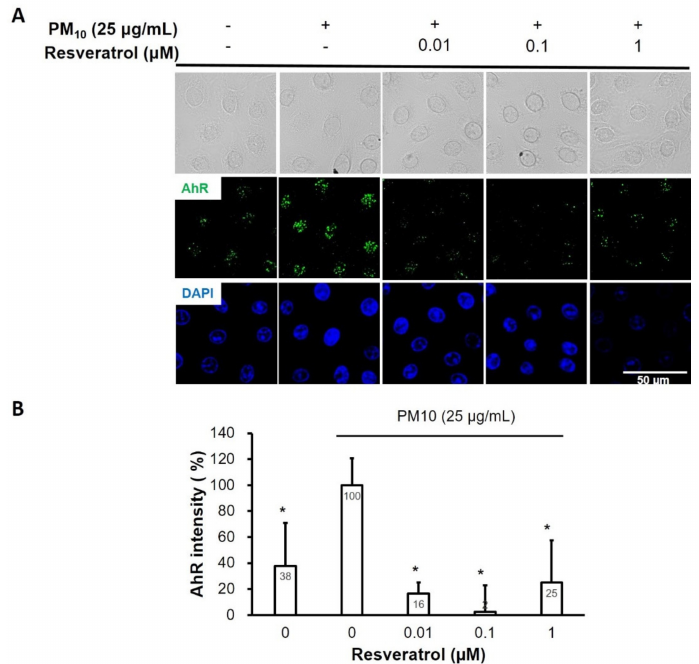
Figure 6. E ff ect of resveratrol on AhR expression in human keratinocytes following PM treatment. ( A ) Confocal microscopic images of AhR expressions in keratinocytes (AhR; green, nucleus; blue). ( B ) Relative AhR intensity. Data are presented as the mean ± standard deviation of three independent experiments ( n = 3). * p < 0.01 vs. PM-treated, resveratrol-untreated samples. AhR, aryl hydrocarbon receptor; DAPI, 4,6-diamidino-2-phenylindole; PM, particulate